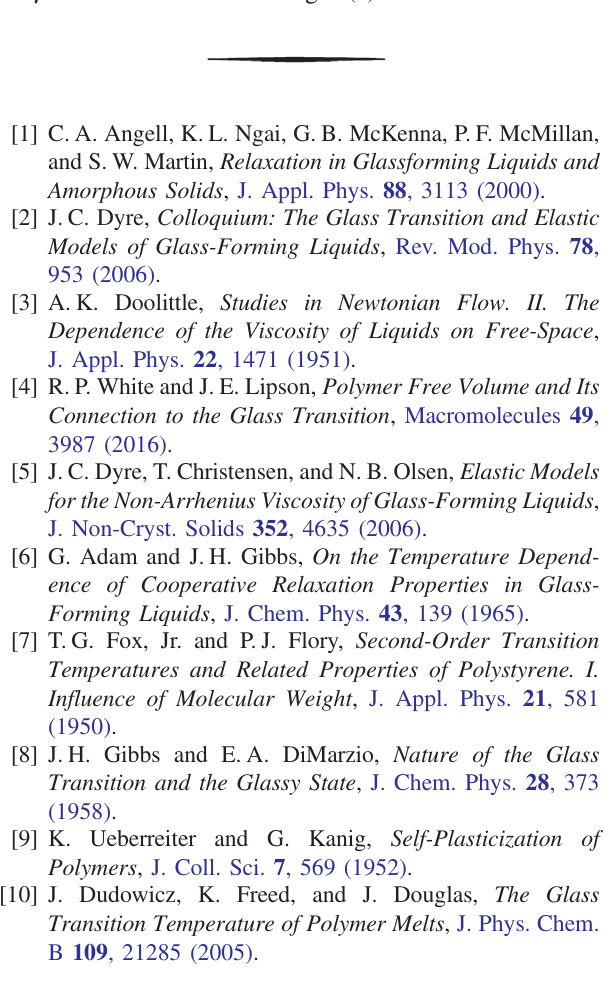
Table VII summarizes the molecular weights and poly- dispersities for the PMMA samples studied, as well as the fitting parameters for the VFTand Arrhenius fits of the α , β , and γ relaxations shown in Fig. 1(a).